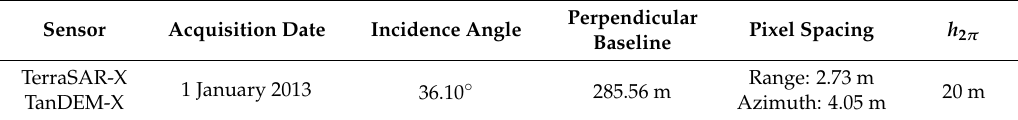
Figure 6. Range of the experimental regions: ( a ) optical image (Tung Chung, source: Google earth); ( b ) optical image (Tsing Yi, source: Google earth); ( c ) interferogram (Tung Chung); and ( d ) interferogram (Tsing Yi). Table 1. Parameters of the used SAR dataset.